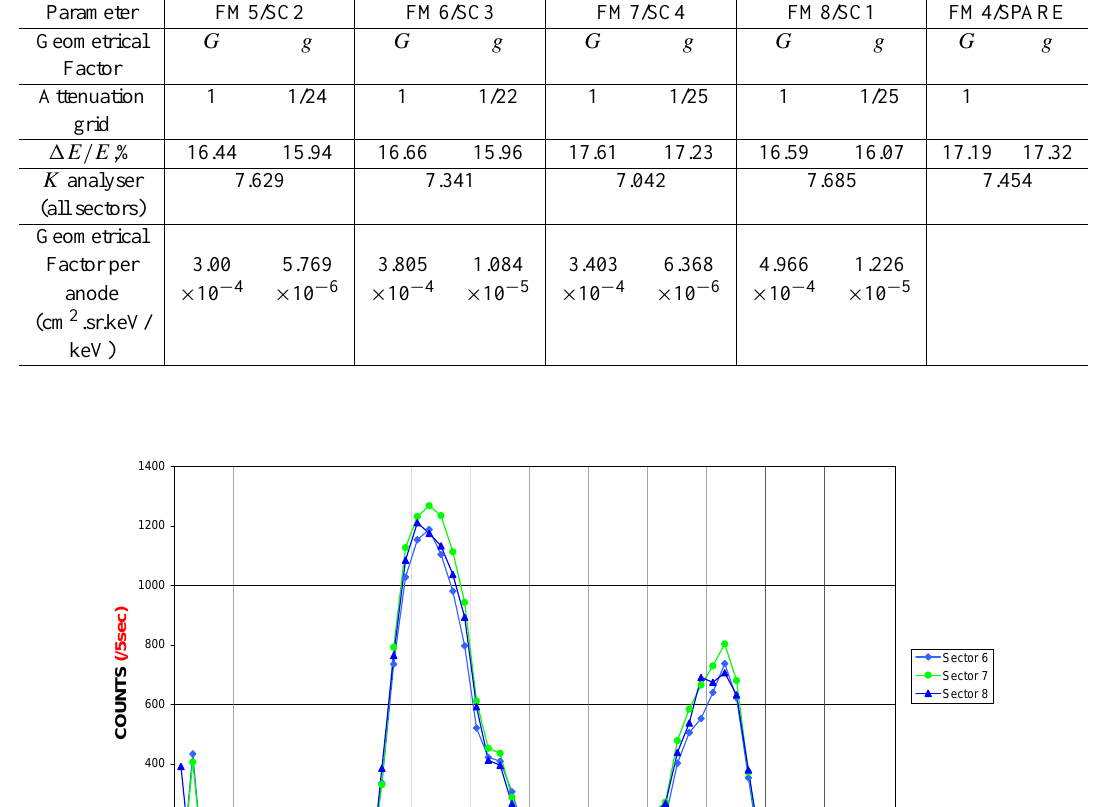
Table 3. Energy resolution, analyser constant and geometrical factor per anode for the four HIA flight models and for the spare model. The high geometrical factor corresponds to sectors 0–15 and the low geometrical factor corresponds to sectors 20–27 (see Fig. 3). These parameters are slightly different from the parameters of the Cluster-1 models due to the modification of the sphere scalloping design used to obtain a better UV rejection (see below)